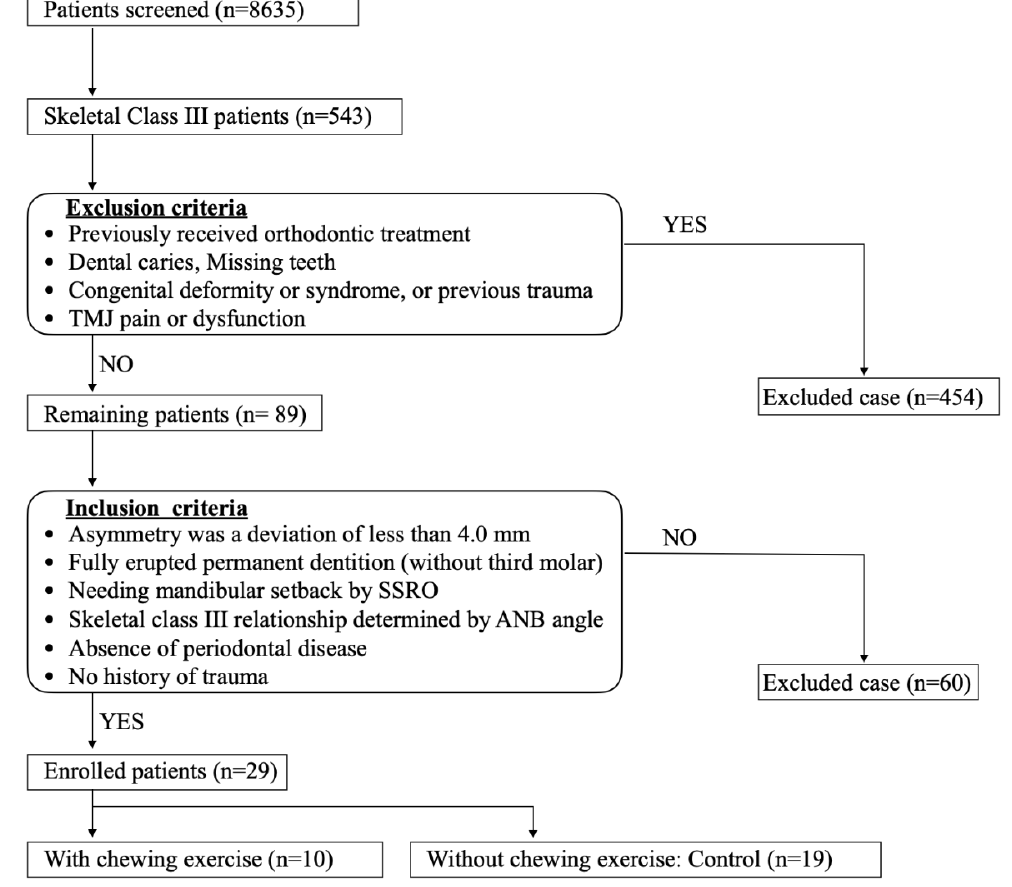
Figure 1. Flowchart of patient enrollment.